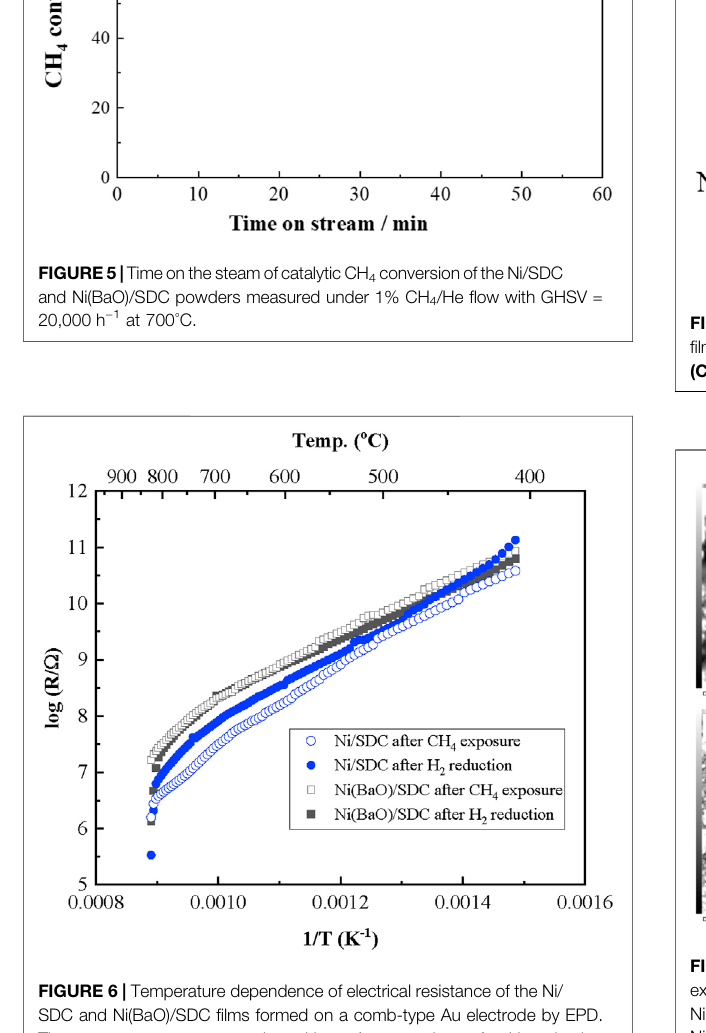
FIGURE 6 | Temperature dependence of electrical resistance of the Ni/ SDC and Ni(BaO)/SDC fi lms formed on a comb-type Au electrode by EPD. The measurements were conducted in an Ar atmosphere after H 2 reduction and after further exposure in CH 4 at 700 ° C.